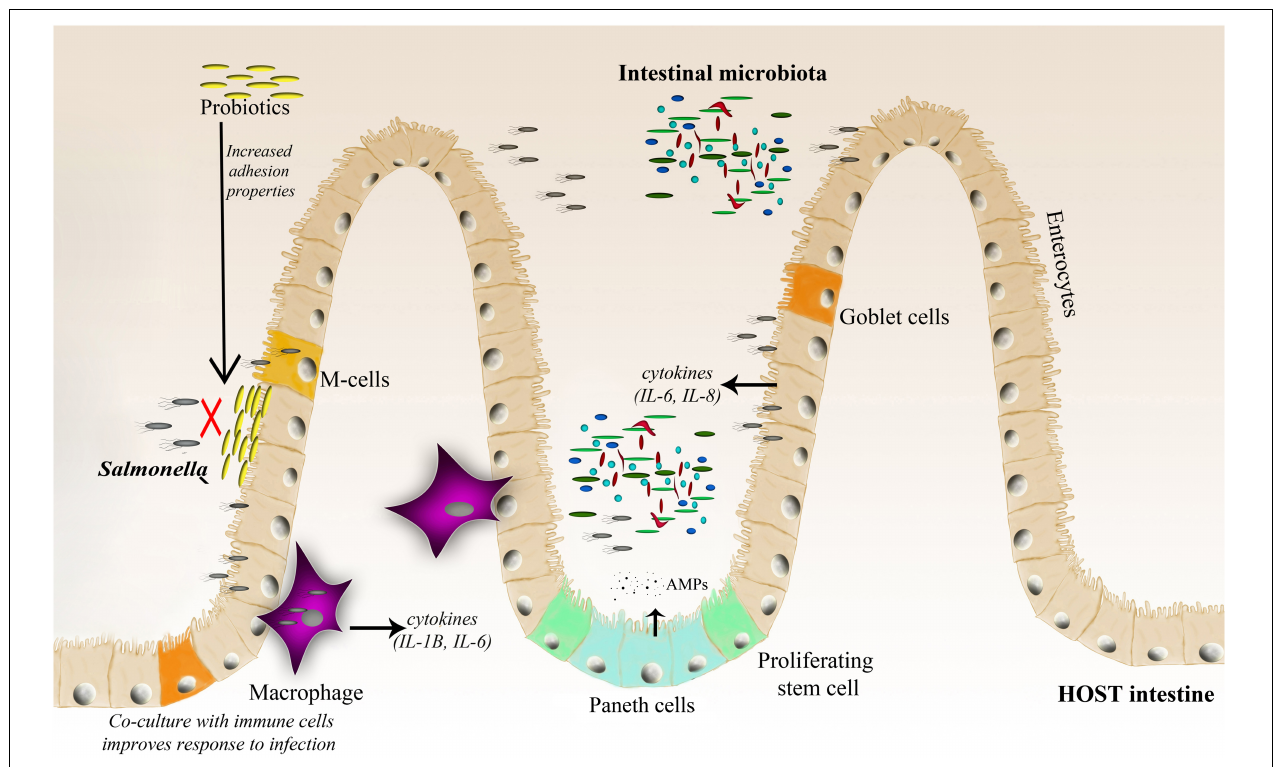
FIGURE 2 | A schematic representation of the Salmonella –host–microbiota interaction. This figure highlights various factors (immune response, microbiota adhesion, and microbiota competition with the invading pathogen) affecting the gut microbiota composition and infection